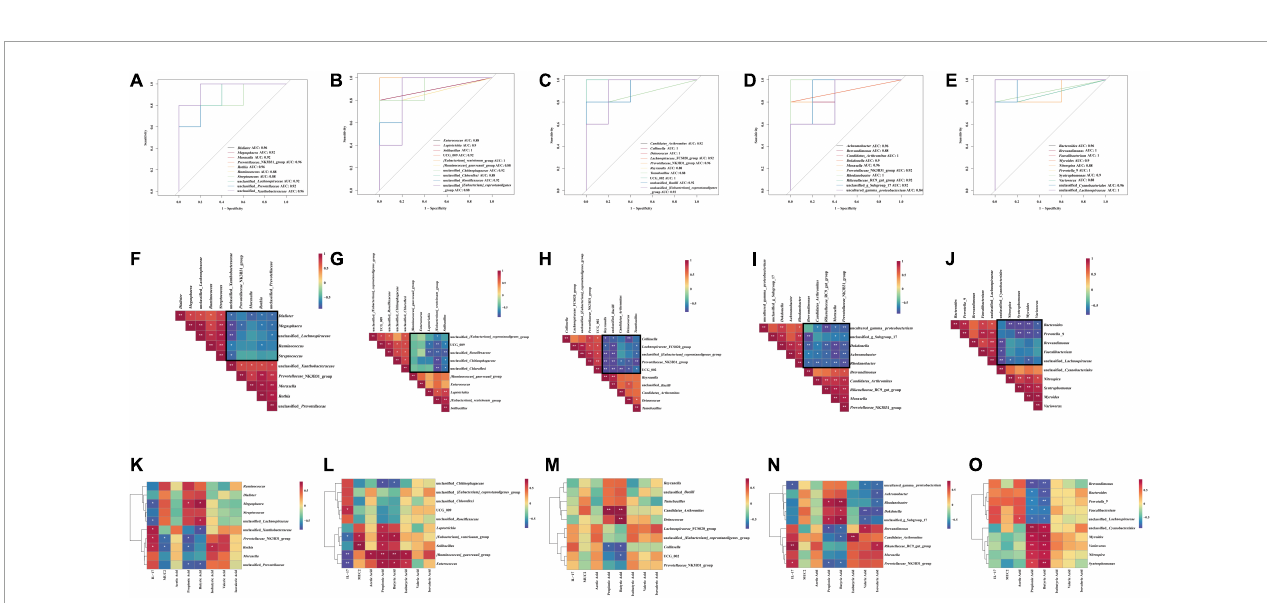
FIGURE8 ROC curve analysis: (A) N group and M group; (B) M group and Q group; (C) M group and LQ group; (D) M group and MQ group; (E) M group and HQ group; Correlation analysis between characteristic genera: (F) N group and M group; (G) M group and Q group; (H) M group and LQ group; (I) M group and MQ group; (J) M group and HQ group; Correlation analysis between characteristic genera, IL-17, MUC2 and SCFAs: (K) N group and M group; (L) M group and Q group; (M) M group and LQ group; (N) M group and MQ group; (O) M group and HQ group. The legend shows the correlation coefficient values. Red represents positive correlation, blue represents negative correlation, and the gradient of color indicates the strength of correlation. * p < 0.05 and ** p <